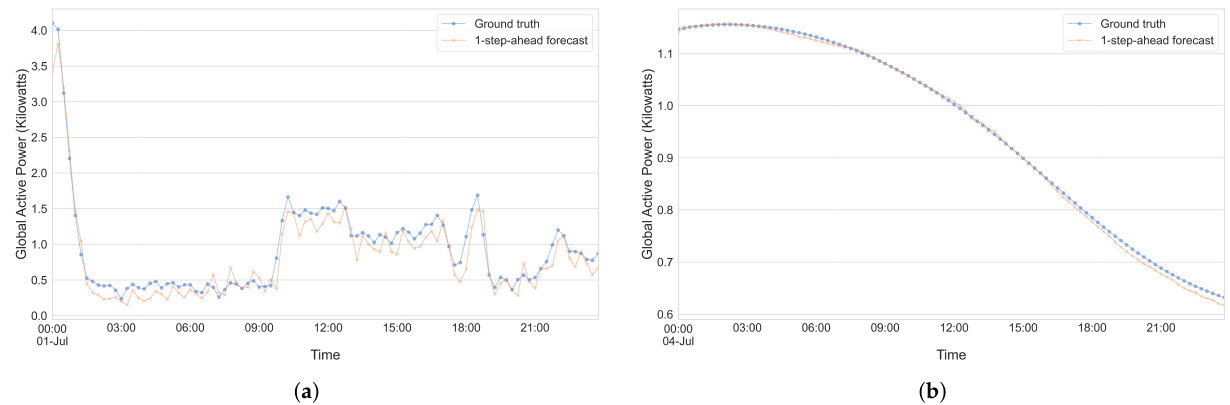
Figure 20. Showcasing the ability of our method to make one-step-ahead predictions on the UCID dataset. ( a ) UCID—Raw data. ( b )